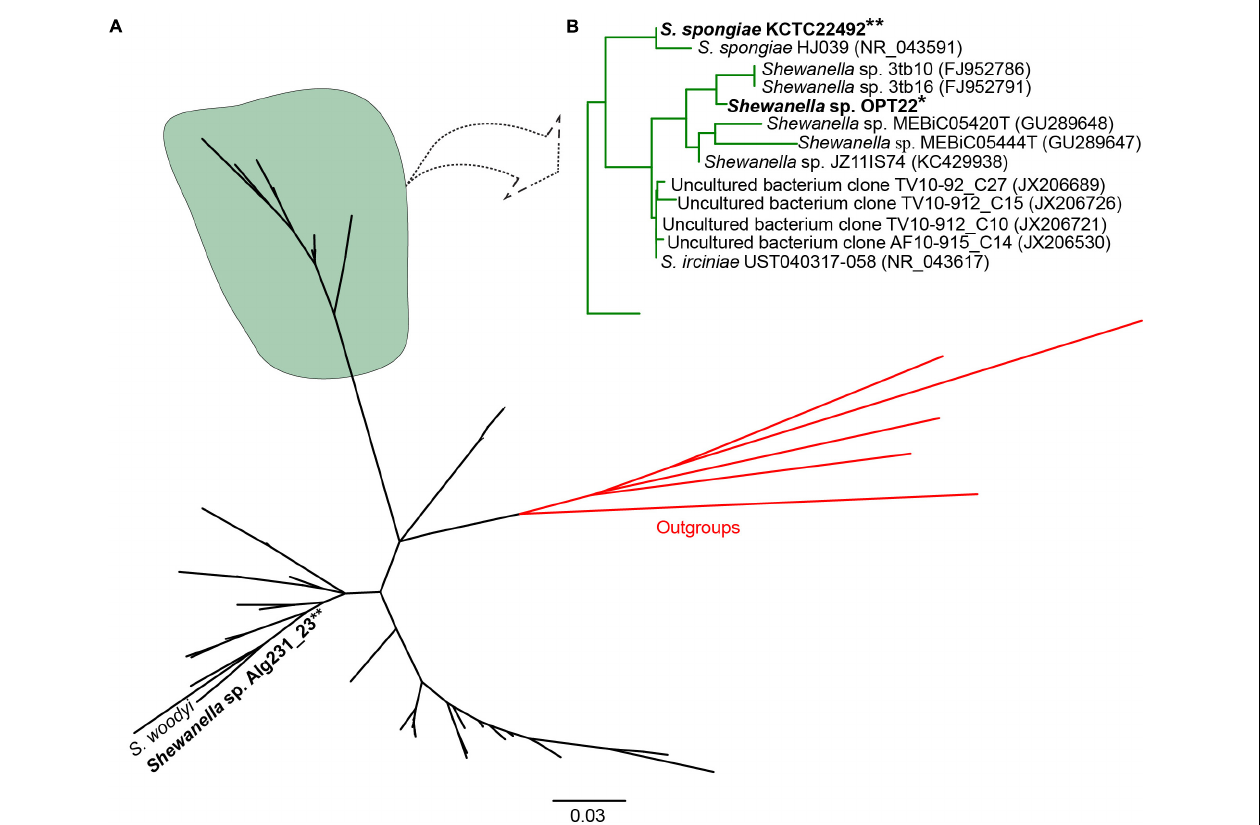
FIGURE 1 | Phylogeny of the genus Shewanella . (A) Phylogenetic tree inferred using the 16S rRNA gene sequences of Shewanella species used for the comparative genomics and the closely related species retrieved from best BLAST hit (shown in Table 1 ). The sponge-specific cluster is shaded in green. Outgroup species are labeled in red. (B) Detailed view of the sponge-specific cluster. Strains in bold denote the only available genomes of sponge-associated Shewanella that are used in this study. The Shewanella sp. OPT22 sequenced in this study is highlighted by a single asterisk, grouped with other sponge-associated Shewanella strains. Shewanella sp. 3tb10 and Shewanella sp. 3tb16 were isolated from a coral host. Strains with two asterisks denote previously reported sponge-associated Shewanella . The complete phylogenetic tree is provided in Supplementary Figure S1